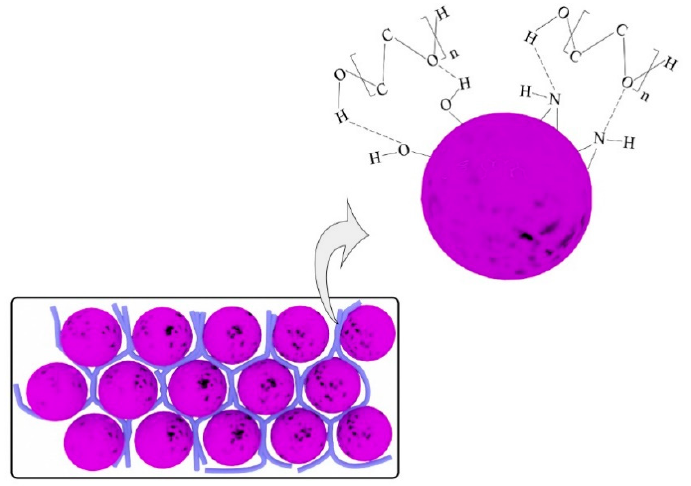
Figure 9. Inferred interaction mechanism between PEG and the PDAMs.